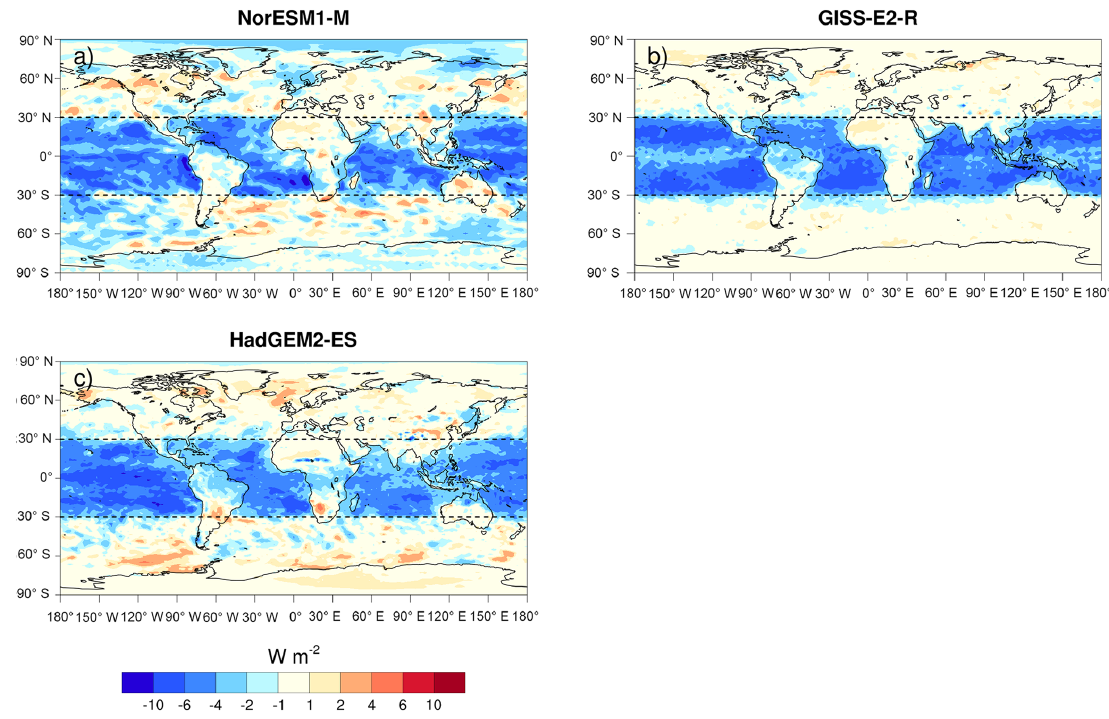
Figure 4. TOA mean effective radiative forcing over the 10 years of simulation with fixed SST for (a) NorESM1-M, (b) GISS-E2-R, and (c)